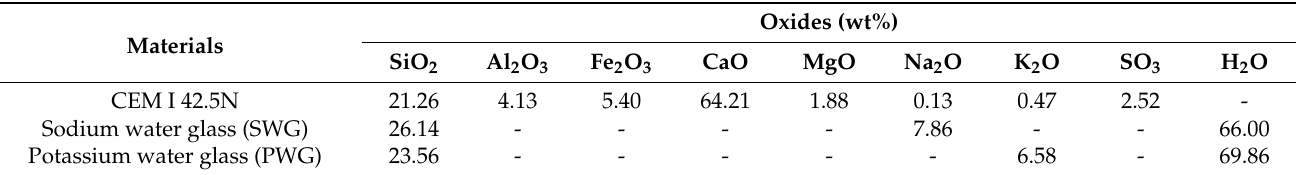
Table 3. Chemical compositions of